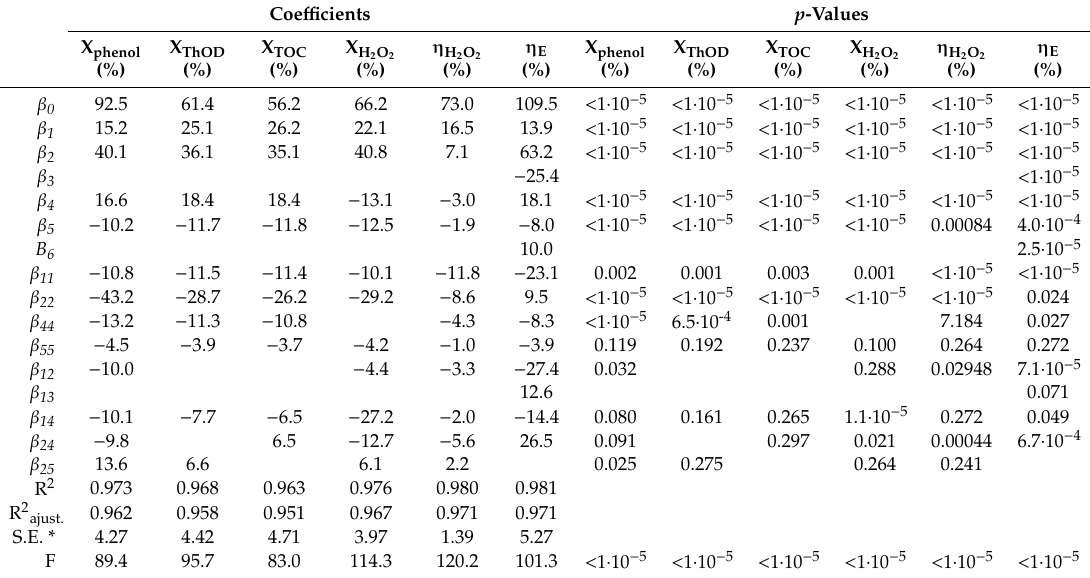
Analysis of variance and significant coe ffi cient values ( p -value < 0.30) for the six responses